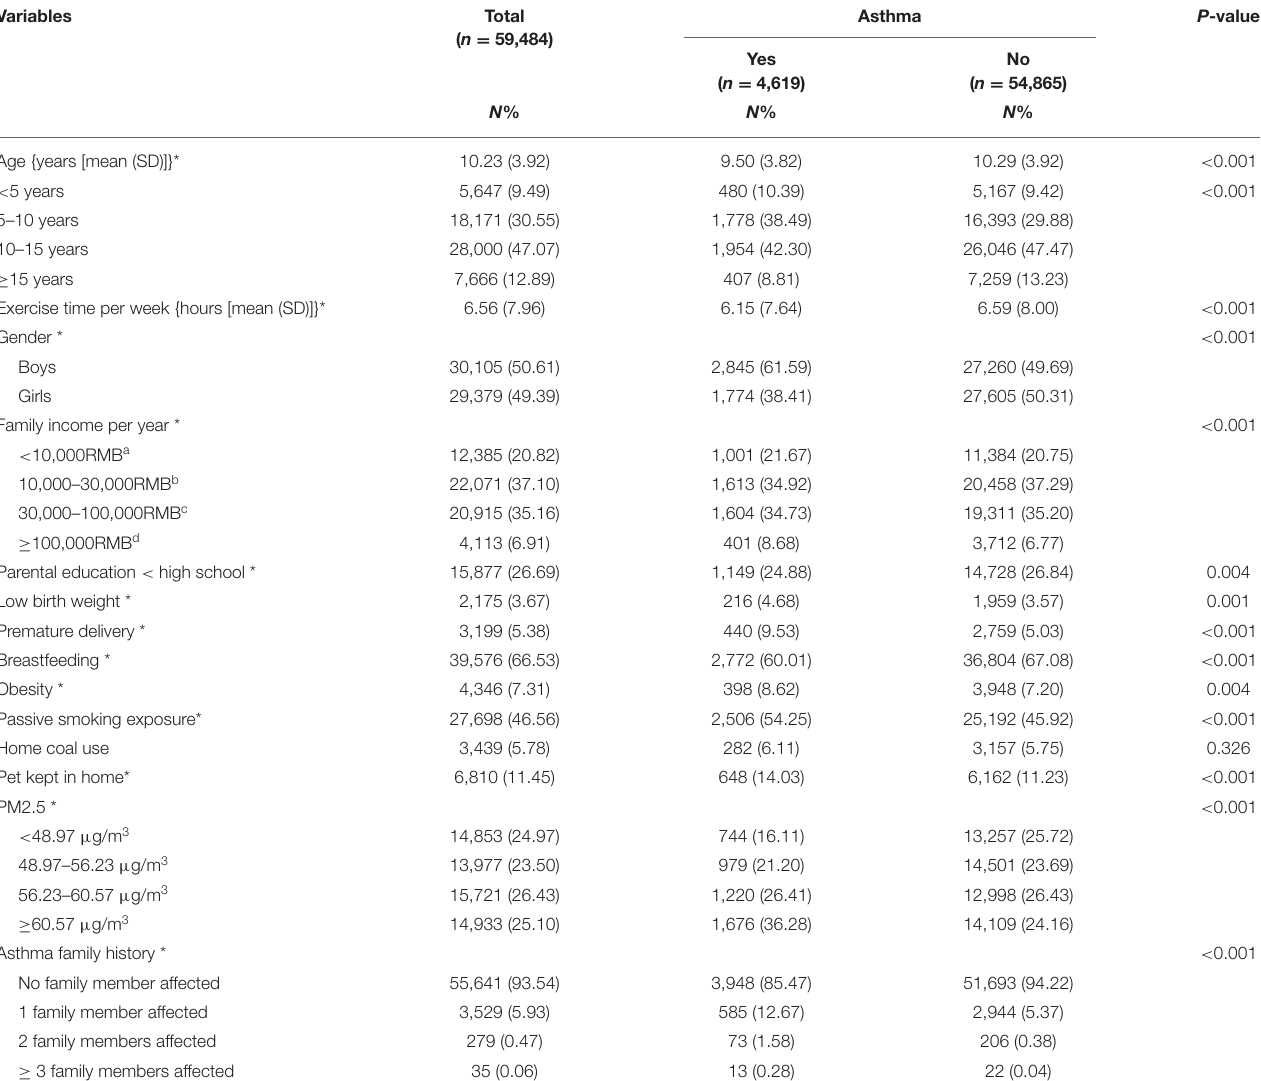
TABLE 1 | Characteristics of